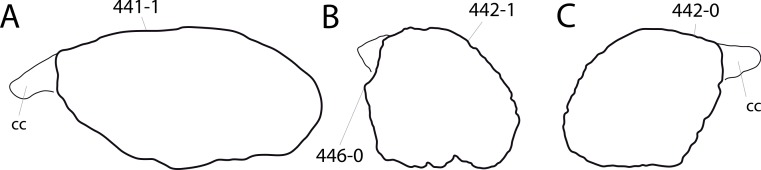
Eusauropod tibiae.Tibia of Omeisaurus tianfuensis ZDM T5701 (A; traced from He, Li & Cai, 1988), Dyslocosaurus polyonychius AC 663 (B), and Apatosaurus louisae CM 3018 (C; traced from Gilmore, 1936) in proximal view. Note the different outlines (anteroposteriorly compressed, A, C441-1; subtriangular, B, C442-1; subrectangular, C, C442-0), and the projection posterior to the cnemial crest (B; C446-0). Abb.: cc, cnemial crest. Scaled to same anteroposterior length.